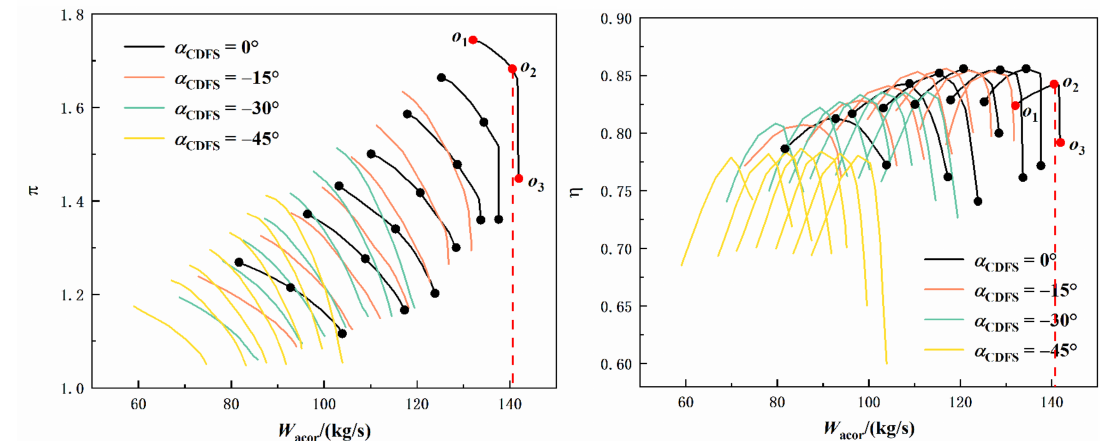
Figure 5. Diagram of selected operating